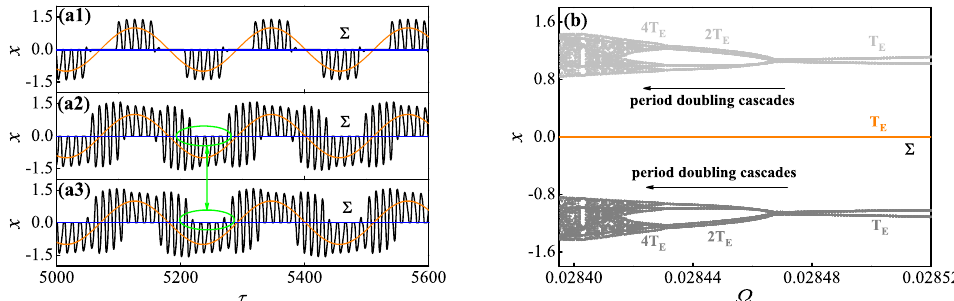
Figure 13. Coexisting responses with Ω = 0.0285 as well as the Poincaré map of whole system. ( a ) The three coexisting period–1 T E responses with Ω = 0.0285; ( b ) the Poincaré map of whole system on the section Π 1 : = w = 0 with Ω ∈ ( 0.0284,0.02852 )